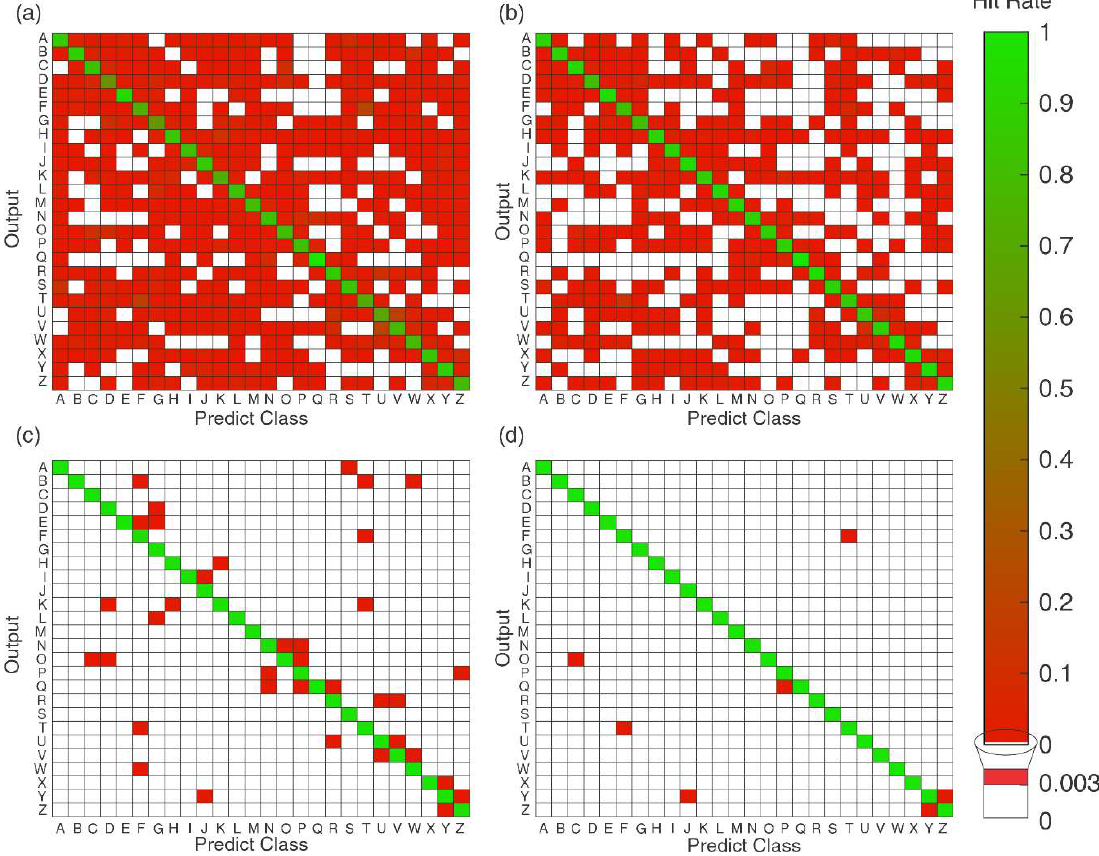
Figure 12. Confusion matrix for random forest classifier for the classes for all subjects using the validation by the acquisition trials, highlighting the influence of overlap rates of 100% ( a ), 50% ( b ), 25% ( c ), and 12.5% ( d ). The color bar represents the accuracy obtained in each case and the white cells represent values less than 0.3% of misclassification samples.